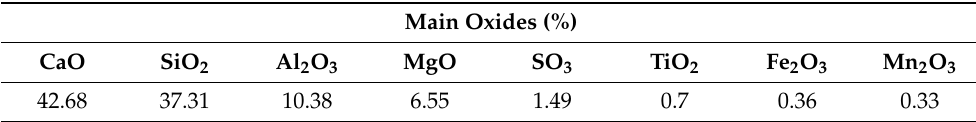
Table 2. Chemical composition of GGBFS (XRF).